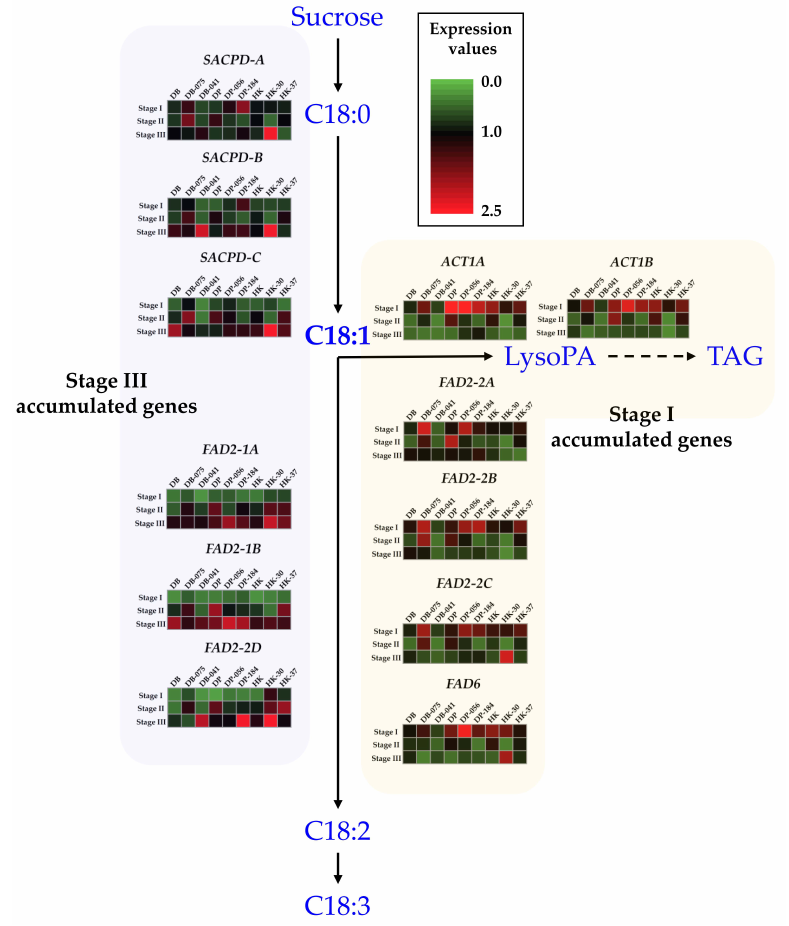
Figure 5. Transcript levels of the 12 major structural genes in the fatty acid biosynthetic pathway. For each gene, the transcript level for six selected mutant lines and three wild-type cultivars analyzed in this study are displayed as a heatmap based on the normalized C t